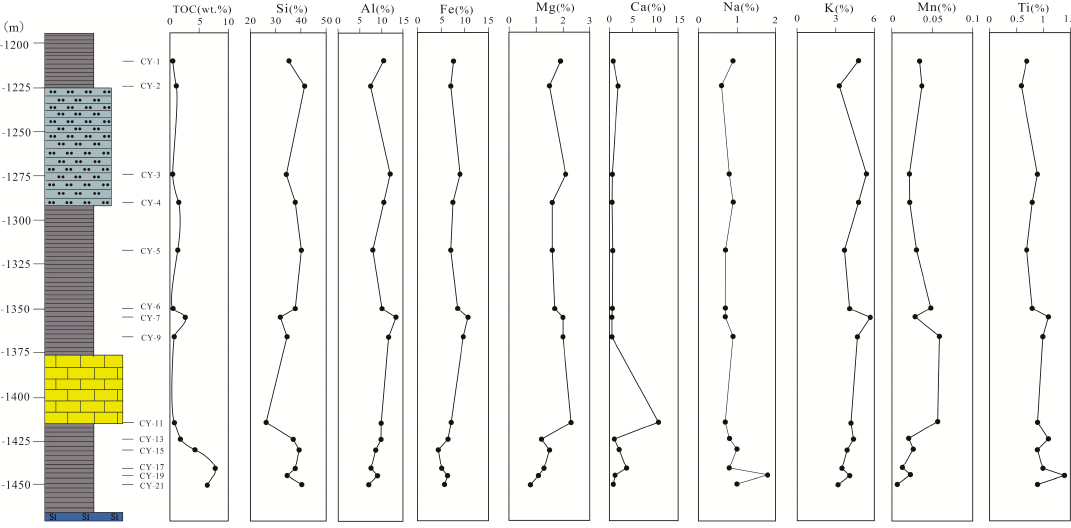
Figure 4. Vertical variation of major elements of the samples in CY-1.